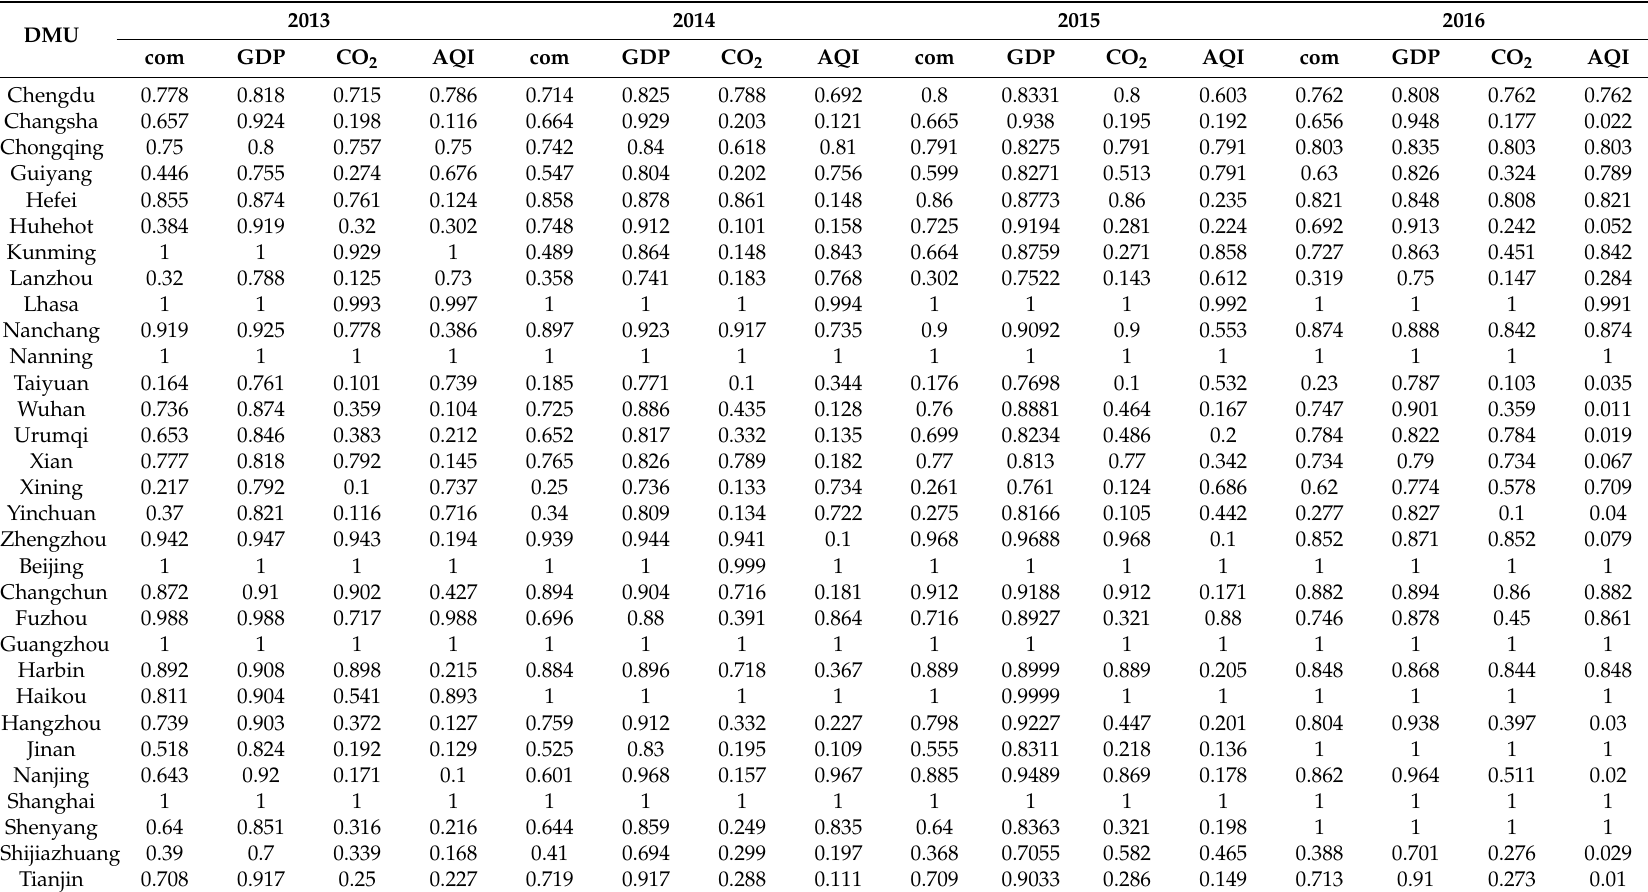
Table 3. Efficiency scores and rankings for energy consumption, GDP, CO 2 , and AQI in the cities from 2013 to